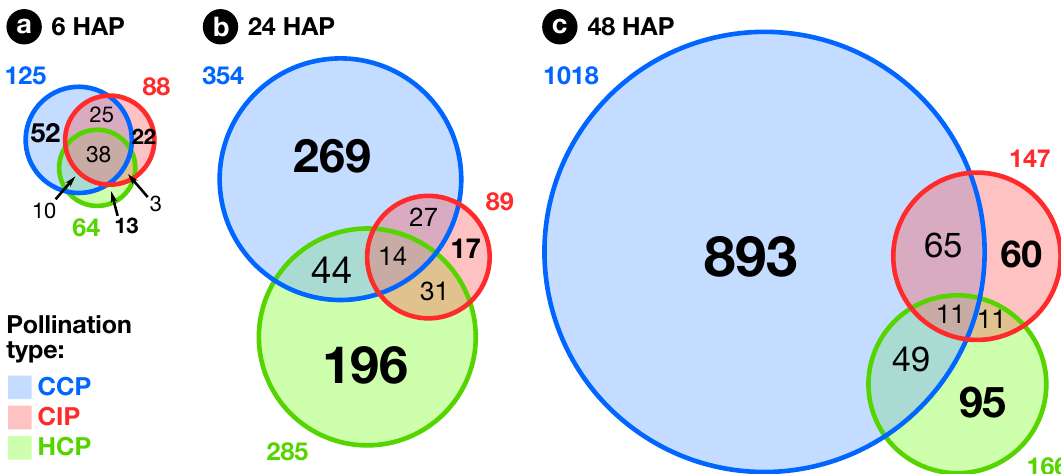
Figure 4. Overlap between pollination responses. Venn diagrams showing the overlap between CCP-, CIP-, and HCP-regulated genes at 6, 24 and 48 h after pollination